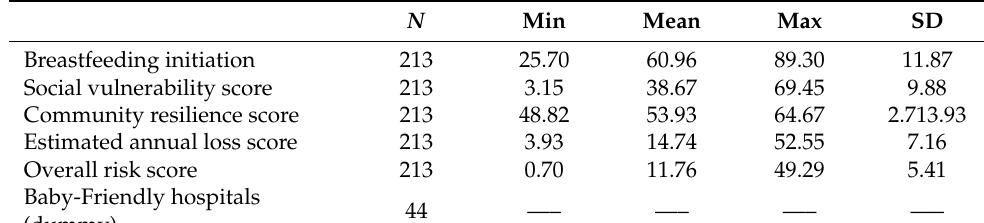
Table 1. Descriptive statistics for key indicators.